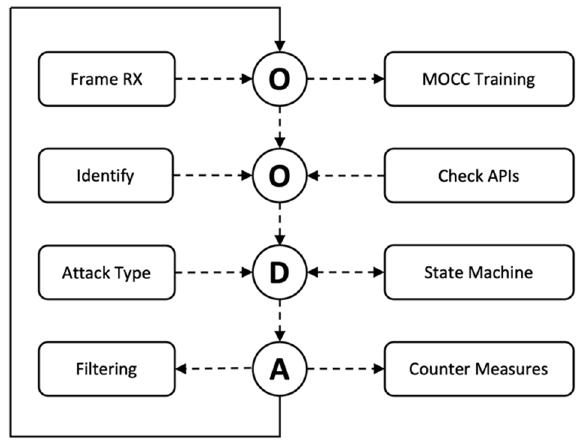
Figure 3. OODA loop functions.